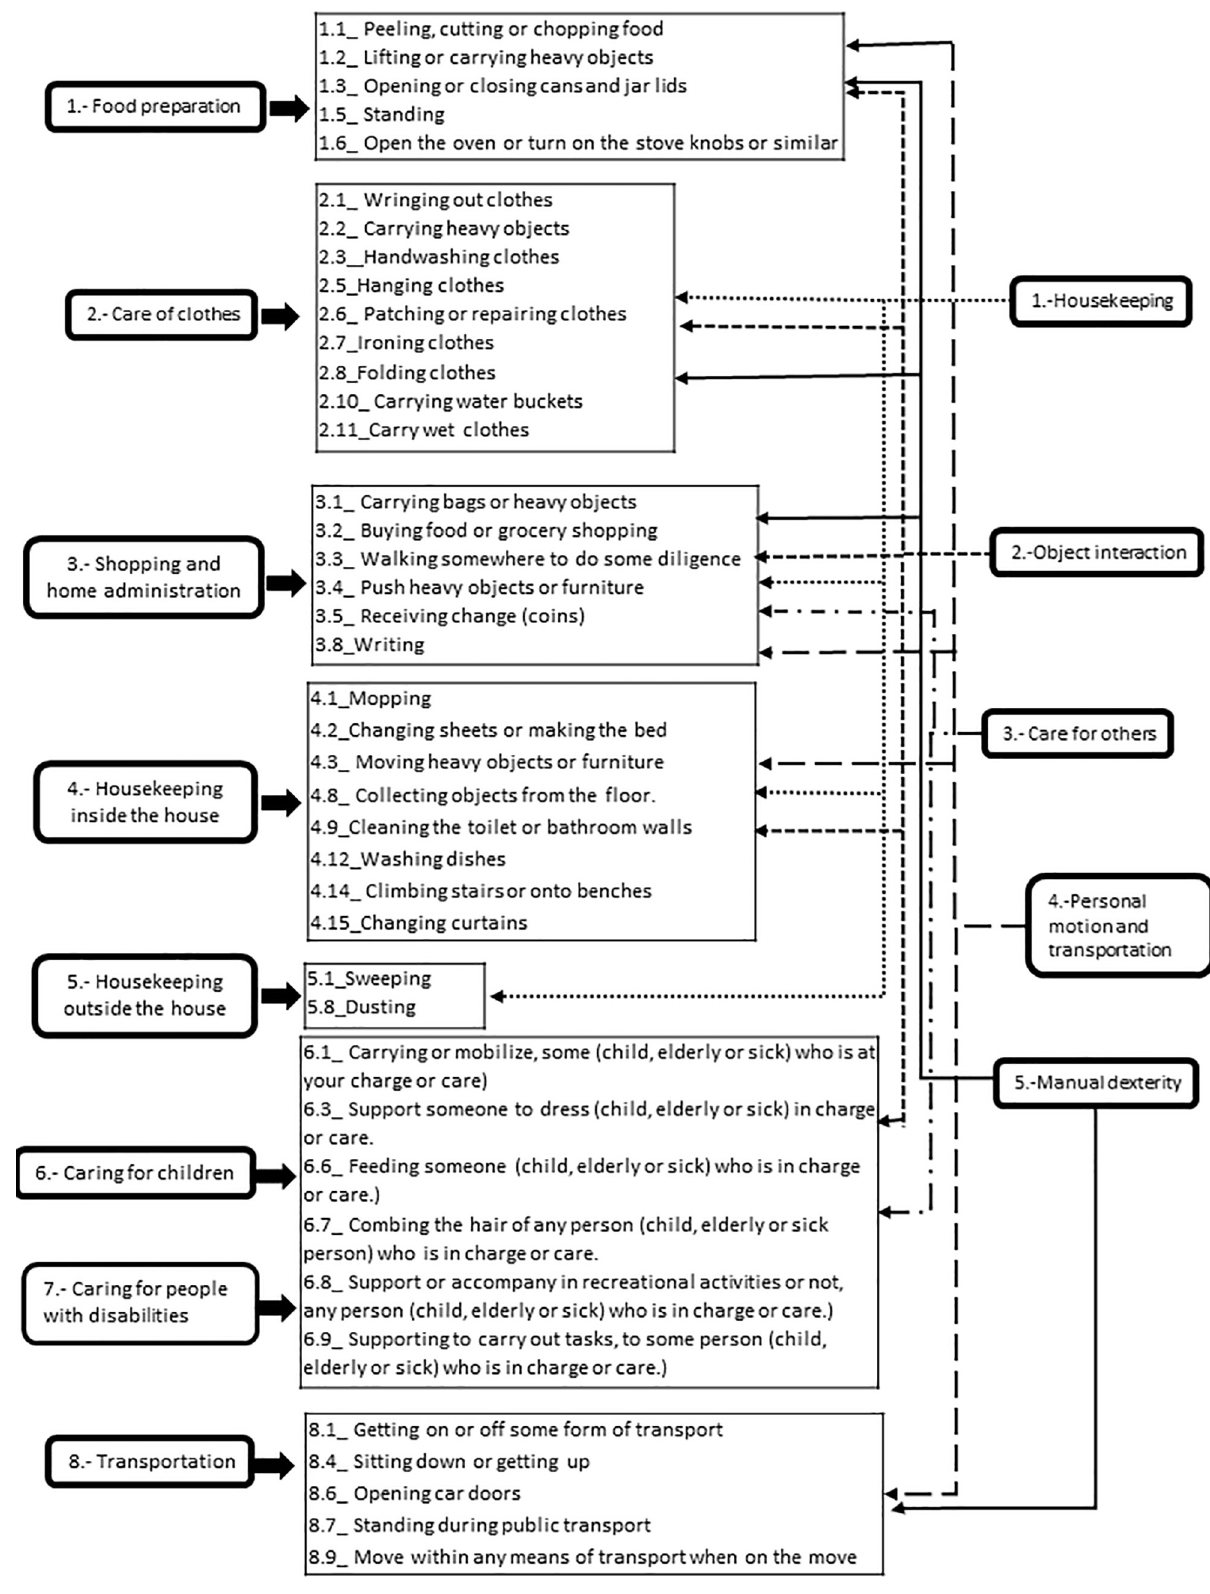
Fig 2. Pre and post-validation HOWL-Q structure. https://doi.org/10.1371/journal.pone.0236167.g002 PLOS ONE | https://doi.org/10.1371/journal.pone.0236167 July 23,